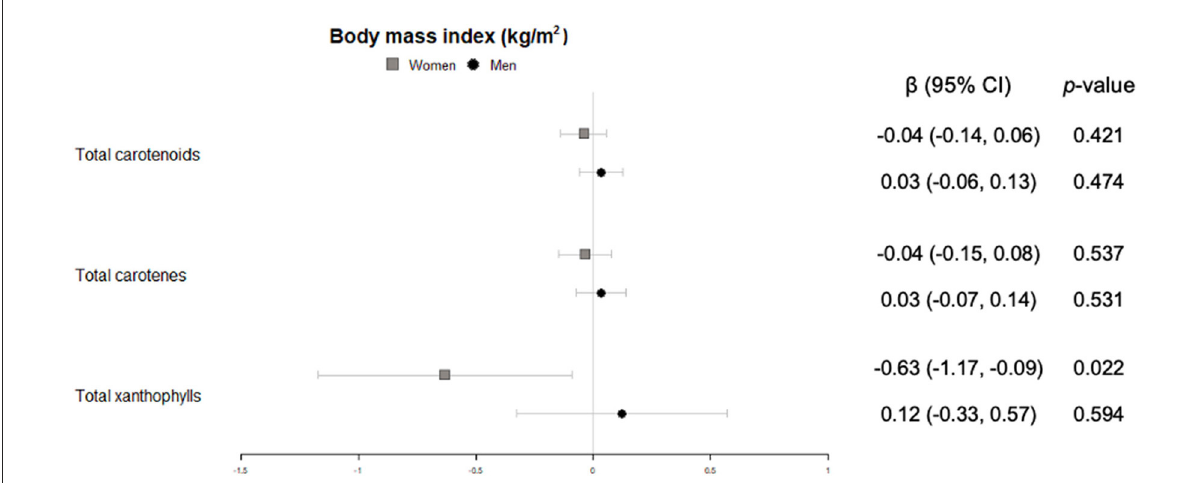
FIGURE1 Cross-sectional association of plasma carotenoids and subclasses (per unit increase) with body mass index (kg/m 2 ) (95%-CI), and their respective p -values.